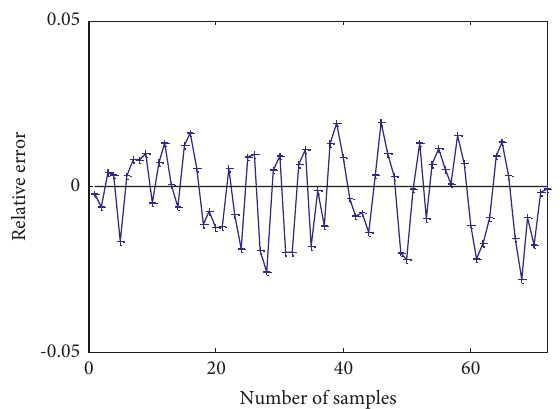
Figure 6: Relative error curve of ethanol concentration based on BSVR soft sensing model.